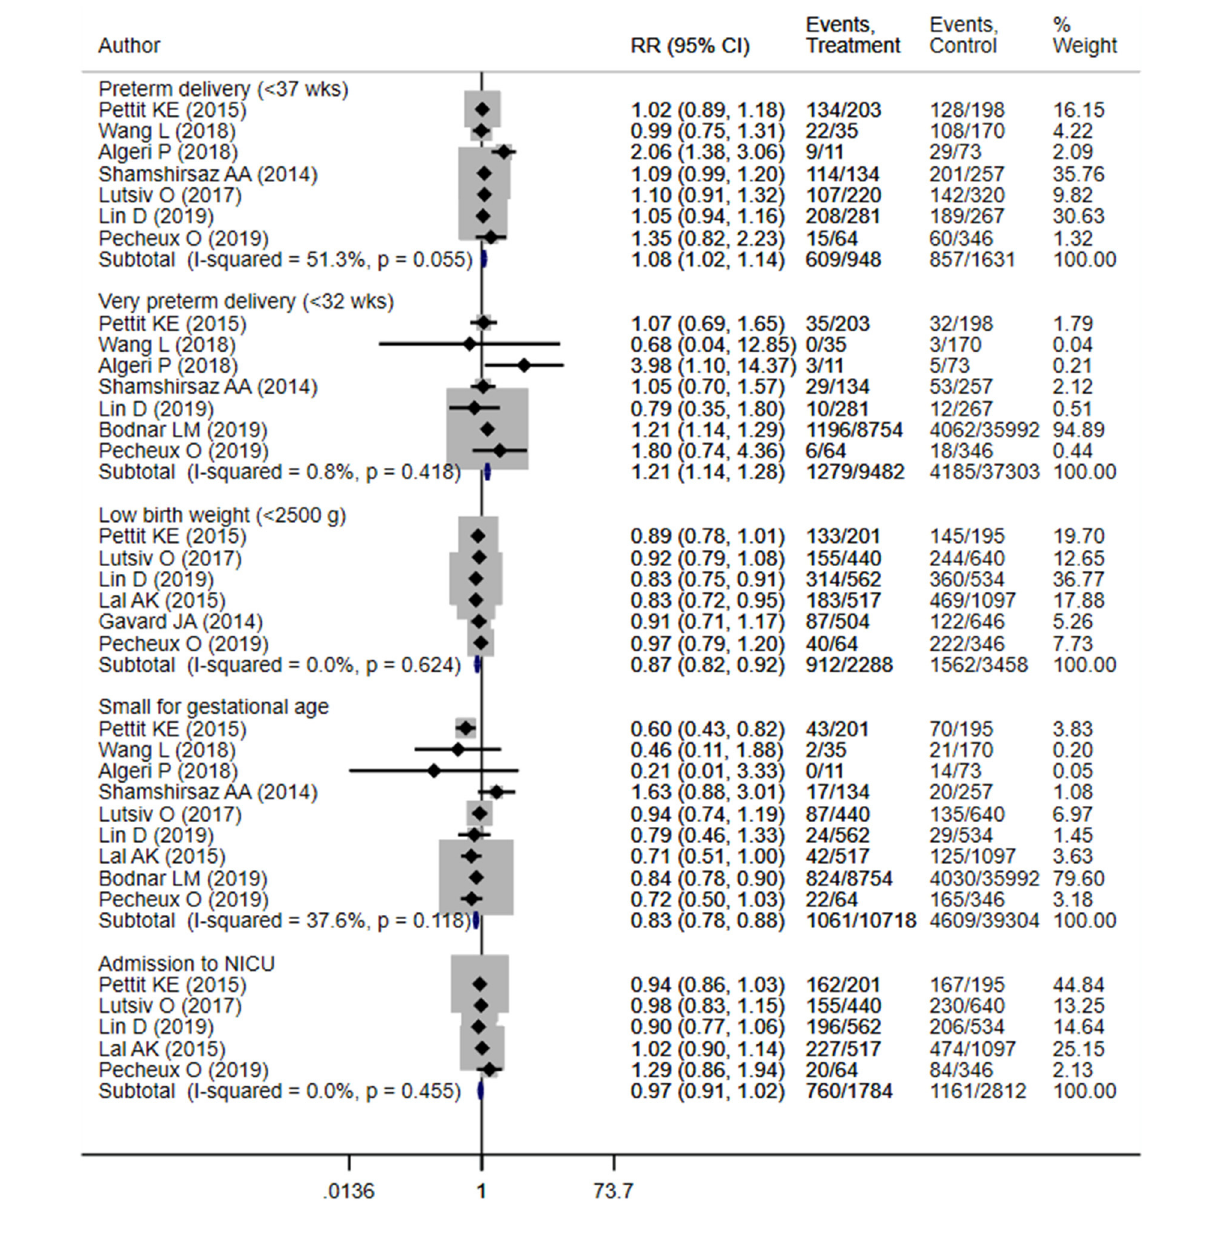
FIGURE 7 | Pooled analysis of excessive or adequate pregnancy weight gain effects on neonatal health